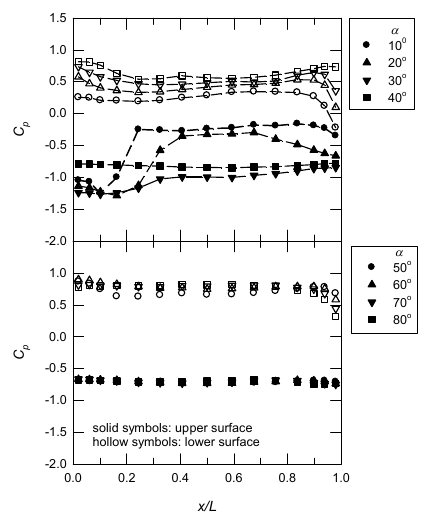
Figure 4. Mean longitudinal pressure distributions at y / W = 0.5; β = 30 ◦ .